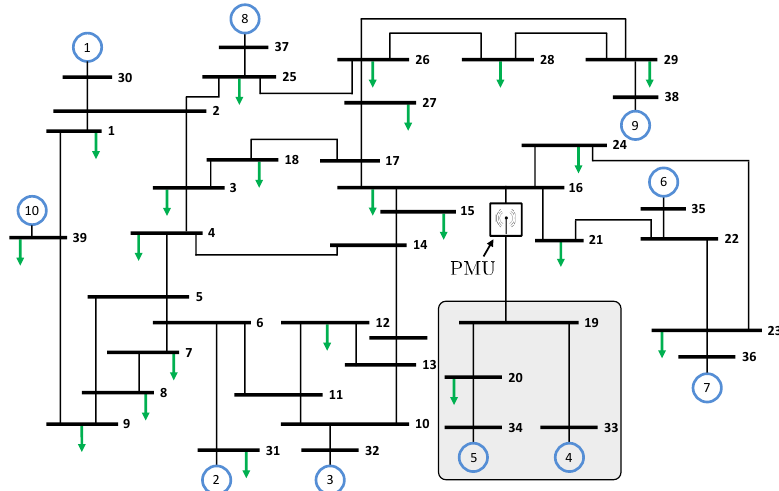
Figure 6. IEEE 39-bus New England system. The area depicted by the grey box, which geographically corresponds to a region in southern Massachusetts, US, is used to test RTVF’s ability to perform wide area predictive modeling.